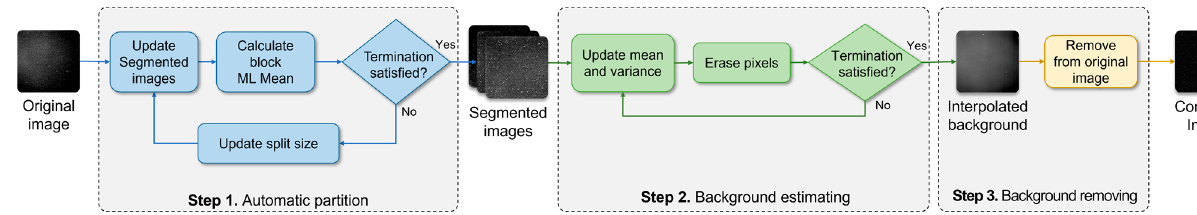
Figure 1. Flowchart of the method.